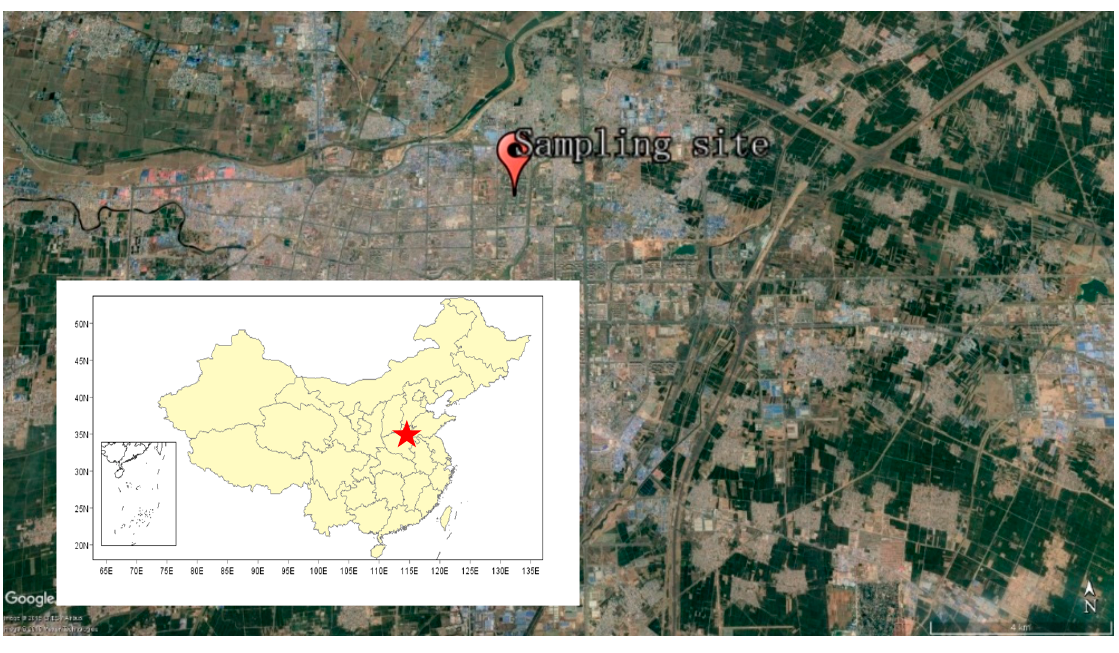
Figure 1. Location of sampling site in Xinxiang.